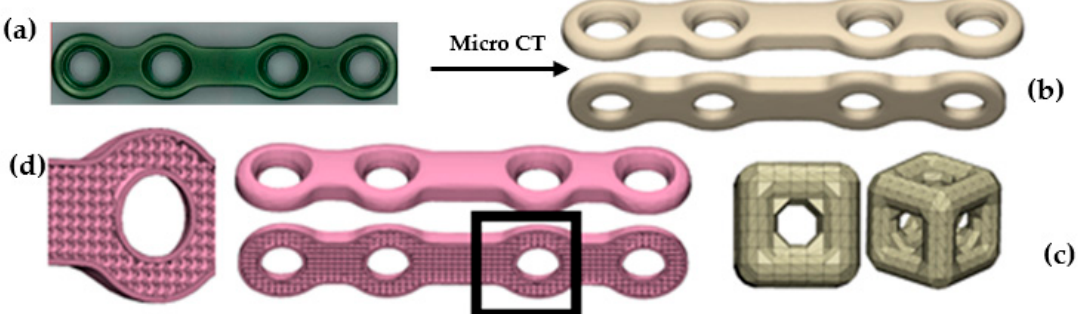
Figure 5. Preparation of a bone fixation plate with an extreme level of porosity and the realistic geometry. ( a ) Conventionally fabricated Ti64 bone fixation plate with standard geometry used as the reference, ( b ) reconstructed CAD through Micro CT, ( c ) porosity cell, and ( d ) porous bone fixation plate.